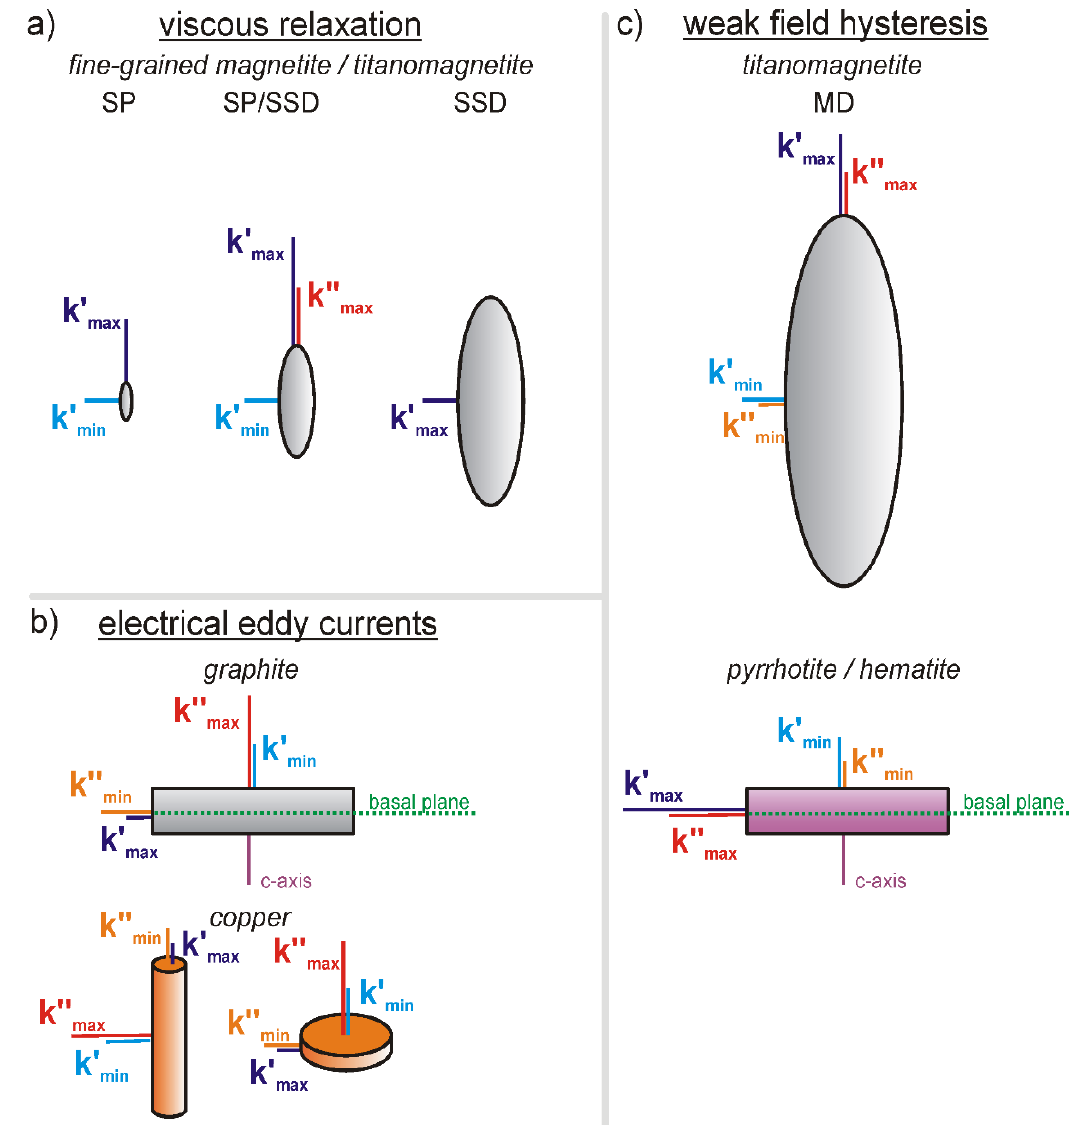
Figure 5. Schematic orientations of maximum and minimum susceptibilities with respect to grain shape or crystal lattice: ( a ) magnetite, titanomagnetite, and maghemite grains with shape anisotropy; ( b ) graphite with magnetocrystalline anisotropy, copper with shape anisotropy; ( c ) titanomagnetite with shape anisotropy, pyrrhotite and hematite with magnetocrystalline anisotropy.